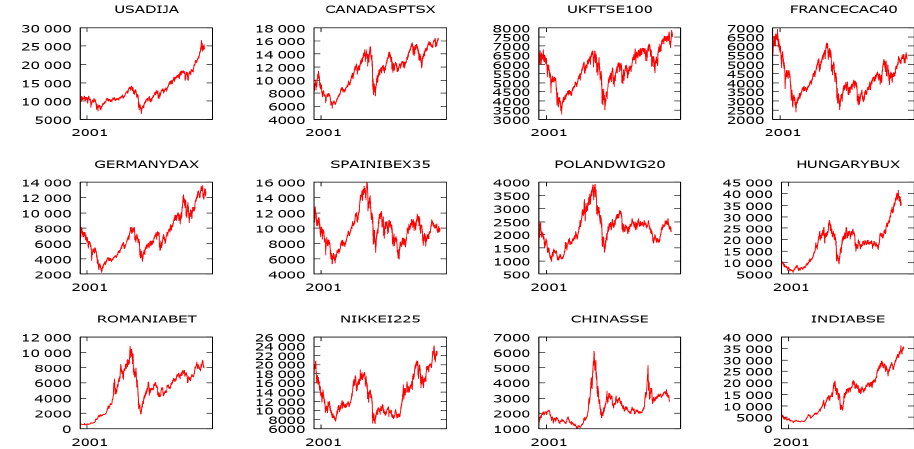
Figure 1. The trend of selected stock market daily returns – individual graphics (source: author’s own